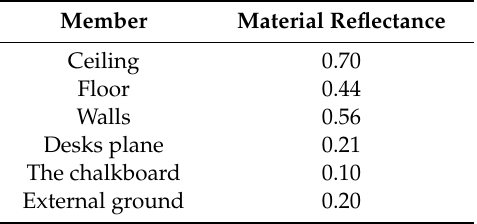
Table 1. Materials’ reflectance of a typical classroom at JUST.